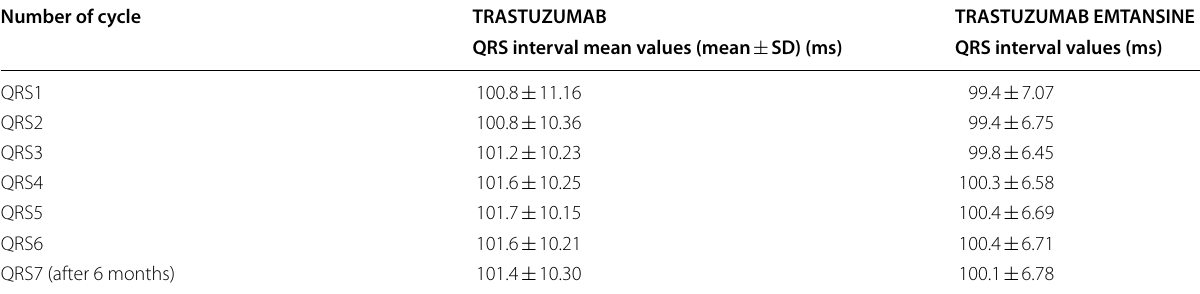
QRS interval values showed no statistically significant difference between trastuzumab/trastuzumab emtansine cycle. The same was found six months after the last application